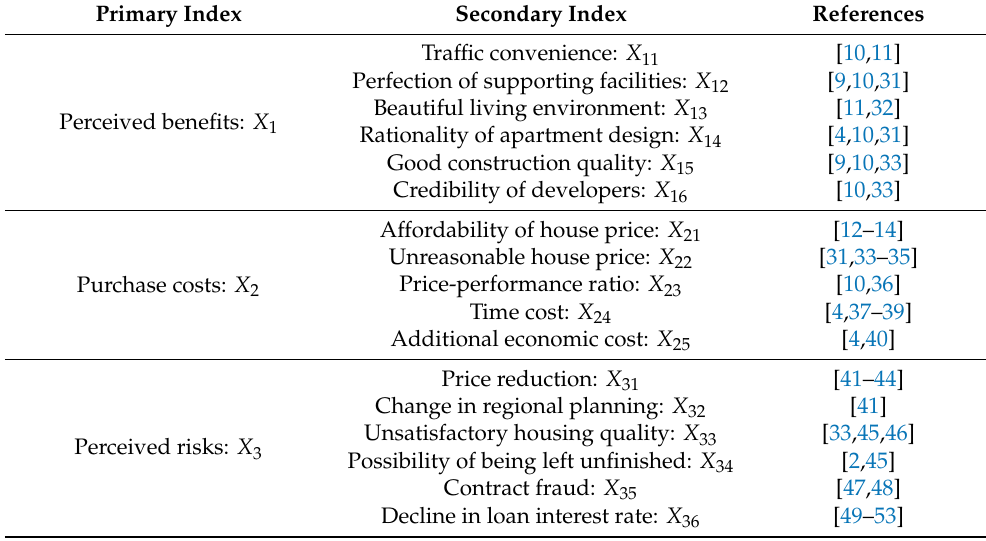
Table 1. Factors influencing Chinese residents’ willingness to buy housing.